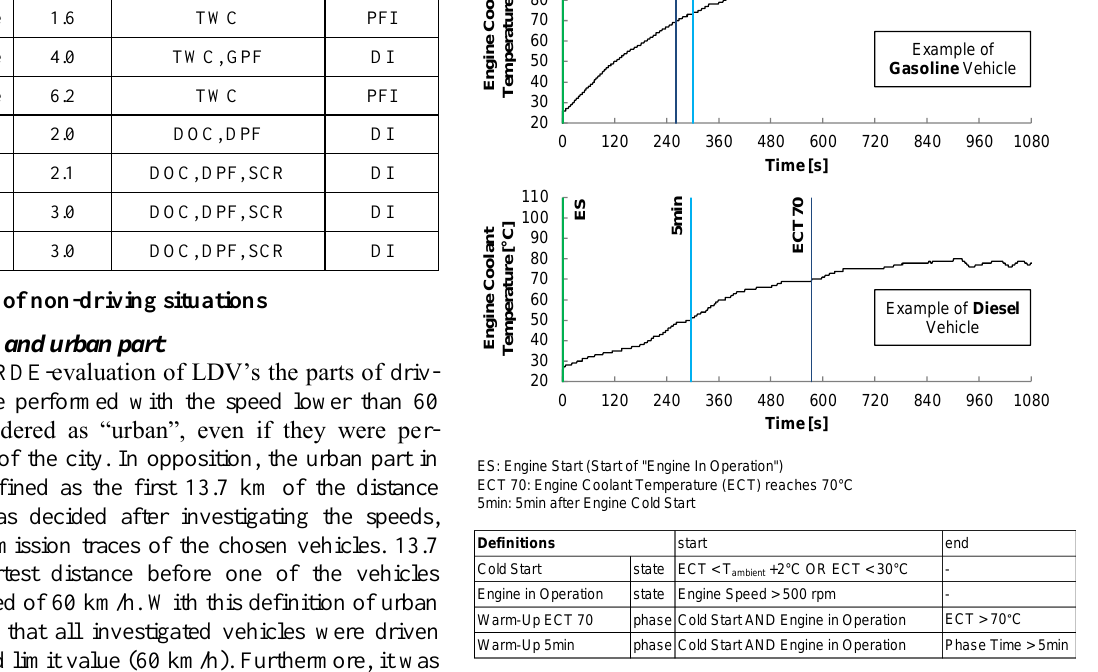
Table 1. List of vehicles chosen for the data evaluation (LDV – light duty No. Fuel LDV01 Gasoline